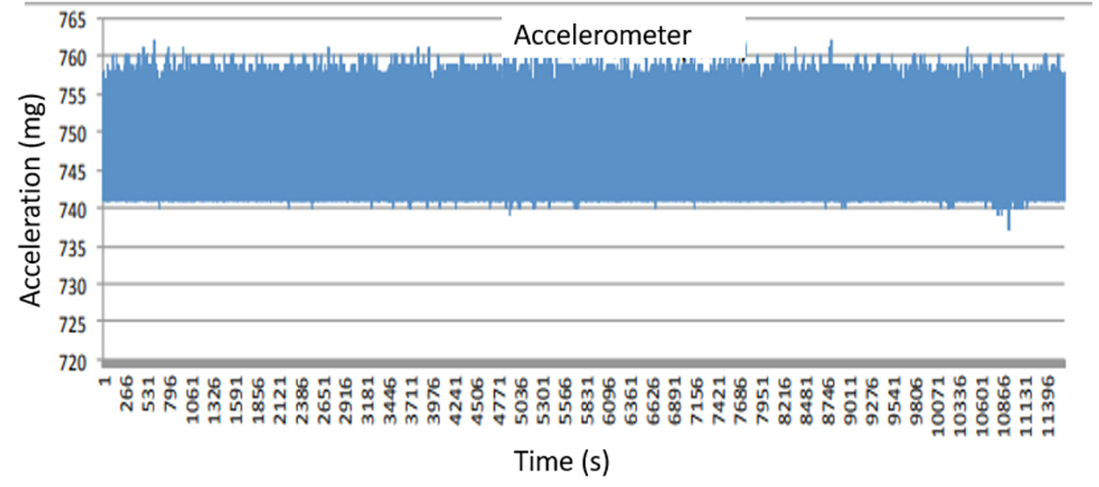
Figure 12. Evolution of the vibrations obtained during the measurement campaign.